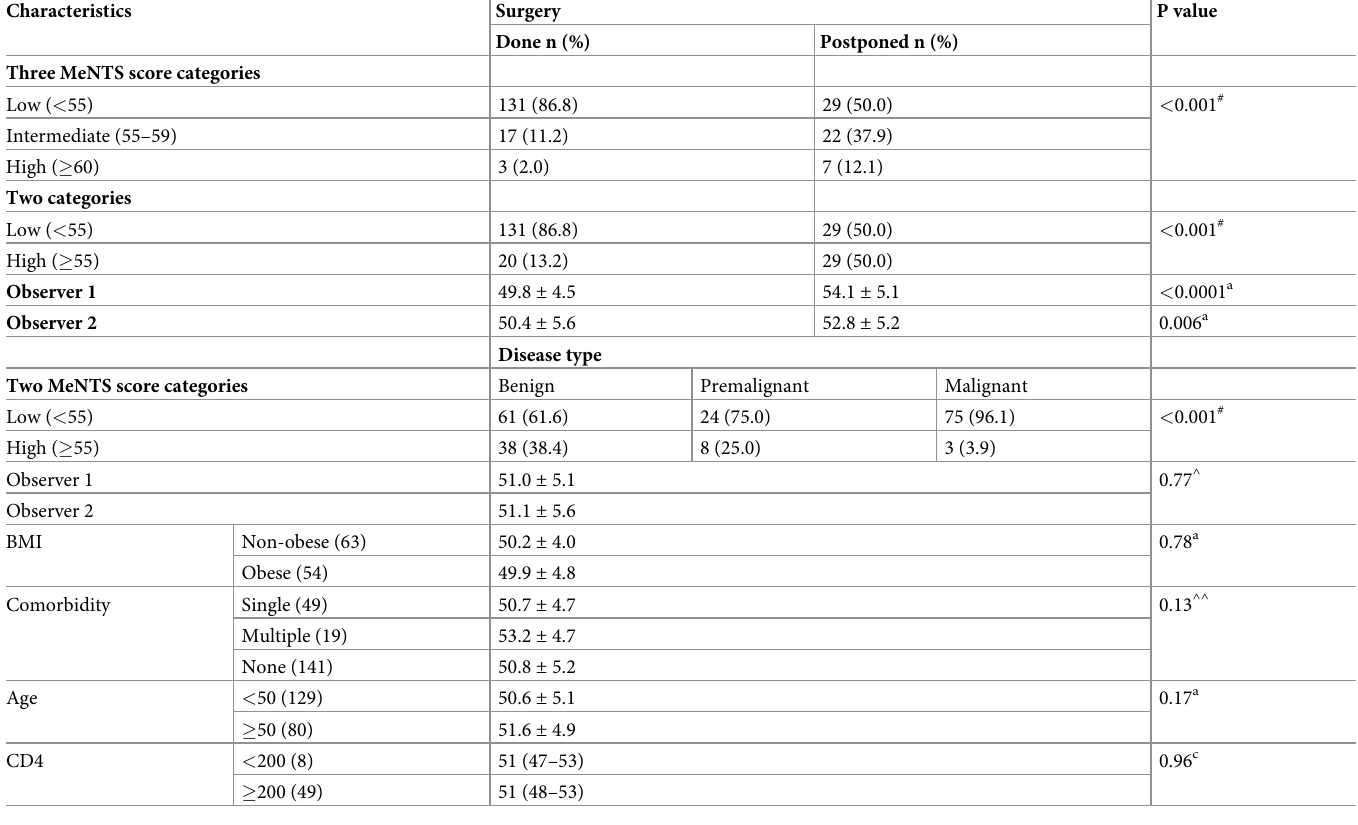
Table 2. Comparison of the cumulative mean scores between observers, across surgery status and other characteristics.